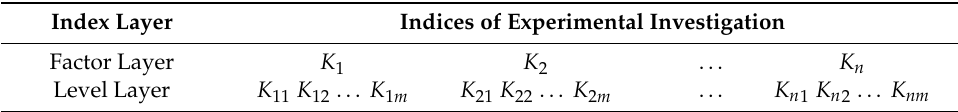
Table 3. Data structure of the weight matrix analysis method.